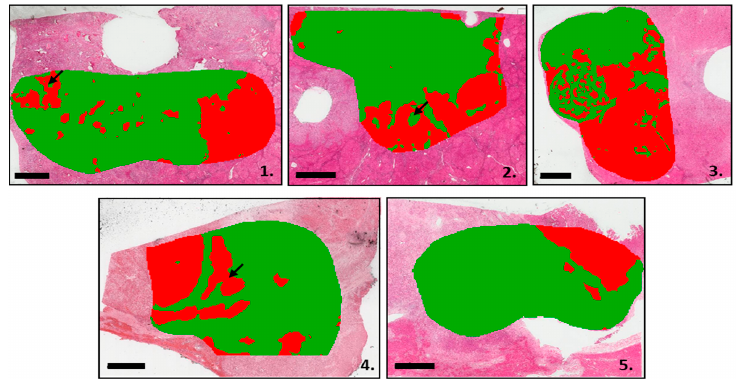
Figure 1. MALDI imaging segmentation analysis. The first arborescence of the segmentation analysis is shown here. Tissues with an hepatocyte component are highlighted in red, while tissues with an iCCA component are shown in green. HCC foci within an iCCA component were indicated by an arrow (1.1, 1.4). The iCCA foci within an HCC component were indicated by an arrow (1.2). Number 1 to 5 correspond to the five cases included. Scale bar = 3 mm .